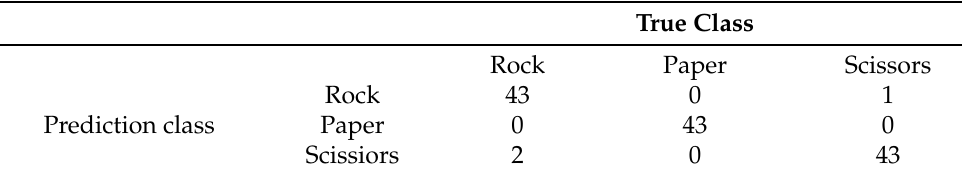
Figure 10. The loss and accuracy of Inception in training process. ( a ) Loss convergence of Inception, ( b ) Accuracy convergence of Inception. Table 3. The confusion matrix of Inception testset (total 132 trials) result in one experiment.